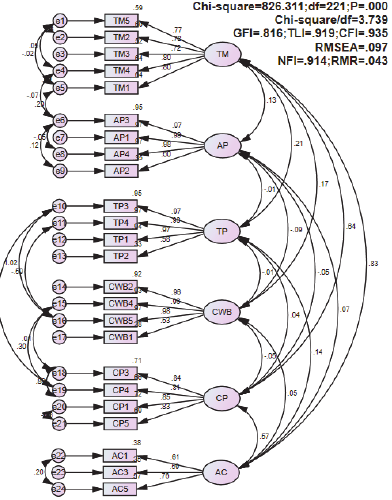
Fig. 1. CFA analysis results following standardized